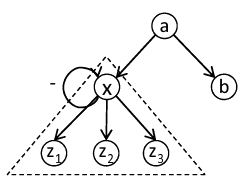
Figure 8: A simple example net-